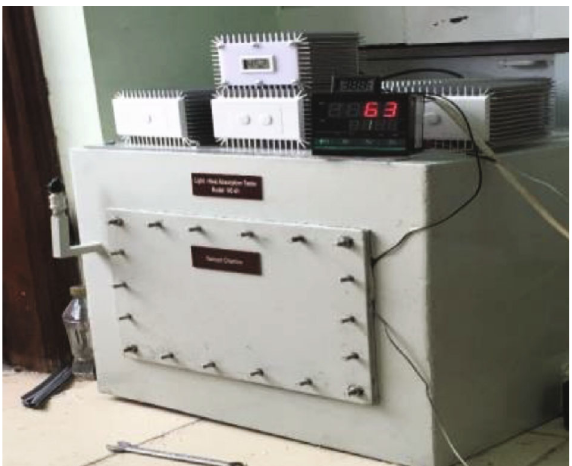
Figure 1: Absorber thermometric system.